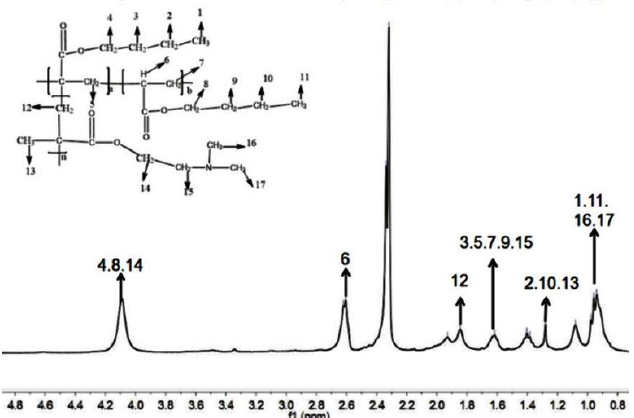
Figure 3. The 1 H NMR spectrum of PBA-g-PDMAEMA synthesized by graft copolymerization.